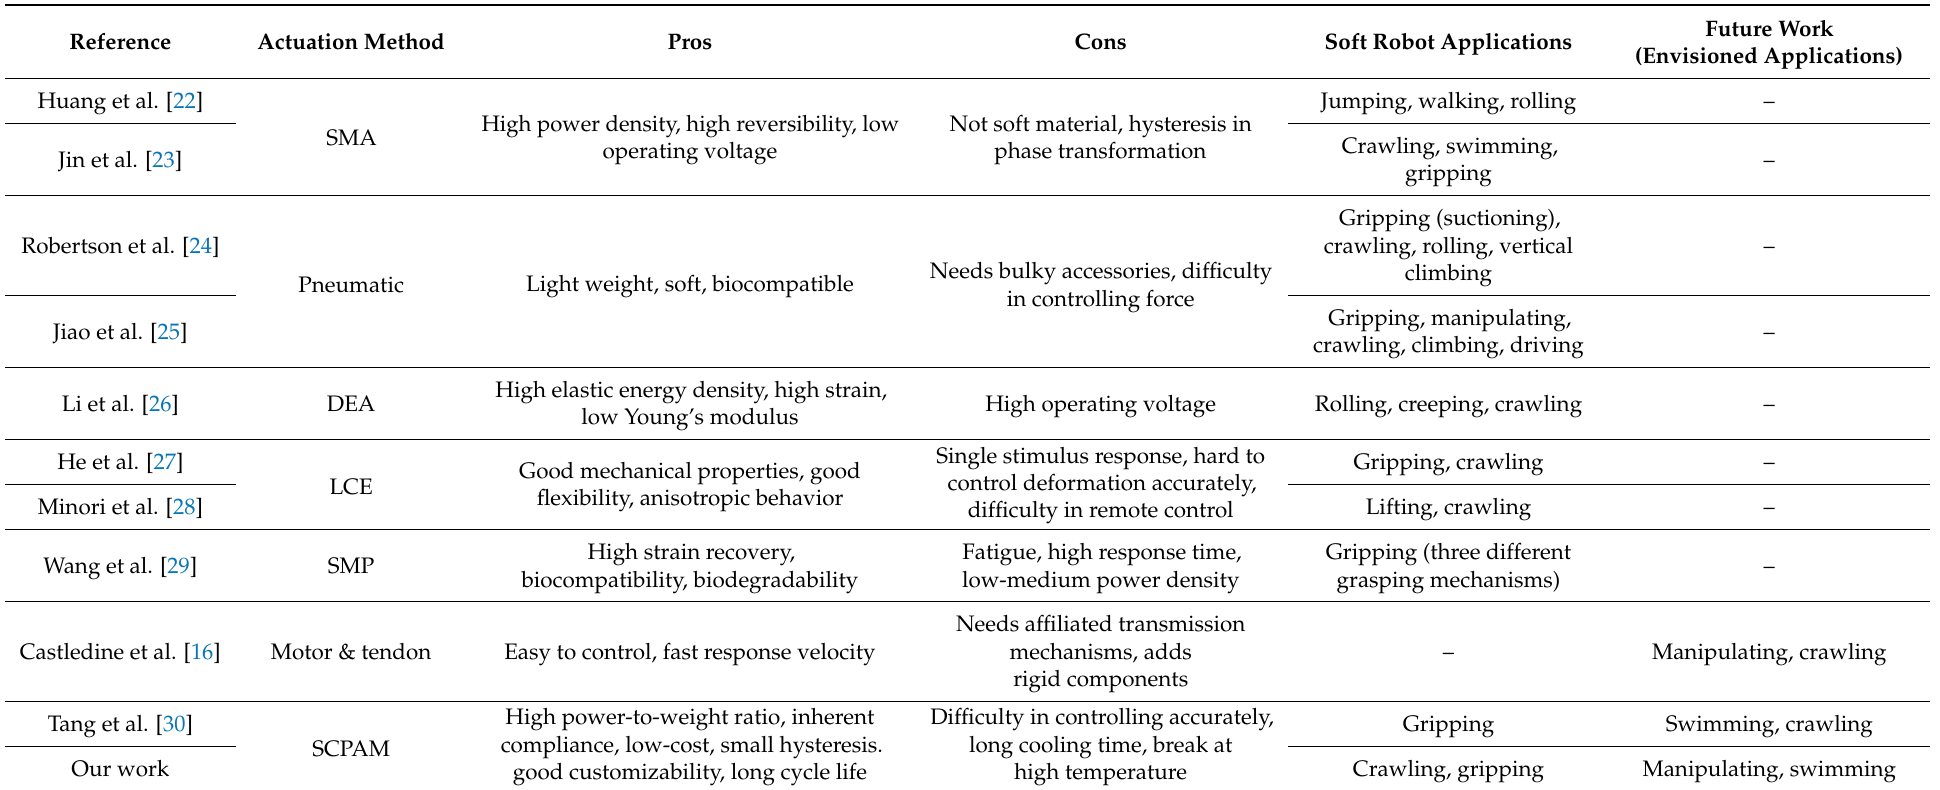
Table 1. Summary of different actuation approaches for soft robot